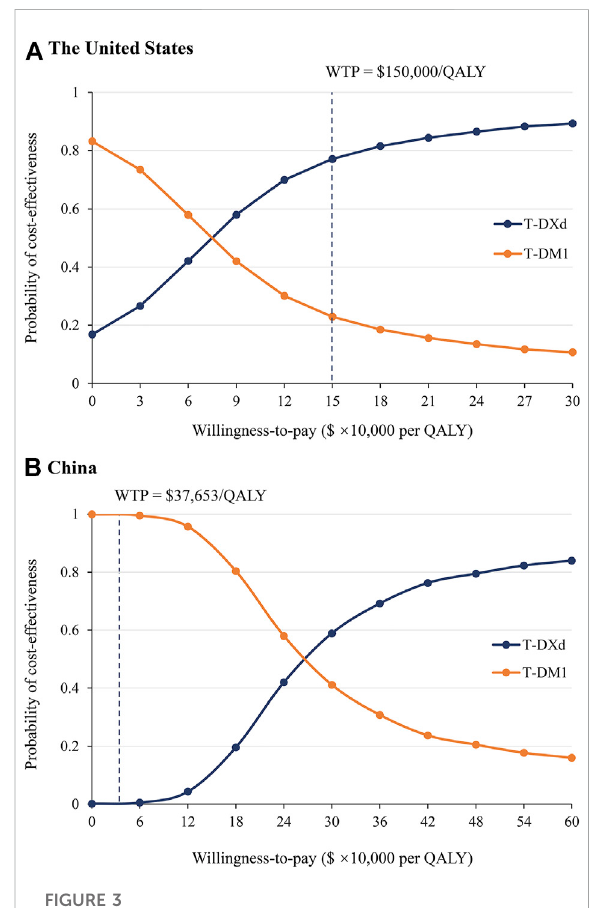
FIGURE 3 Probabilistic sensitivity analysis. Acceptable curves present the probability of T-DXd and T-DM1 being cost-effective at different WTP thresholds from the perspectives of the US (A) and China (B) .Thedarkdottedlinesrepresentthethresholdsused in the study. QALY, quality-adjusted life year; WTP, willingness-